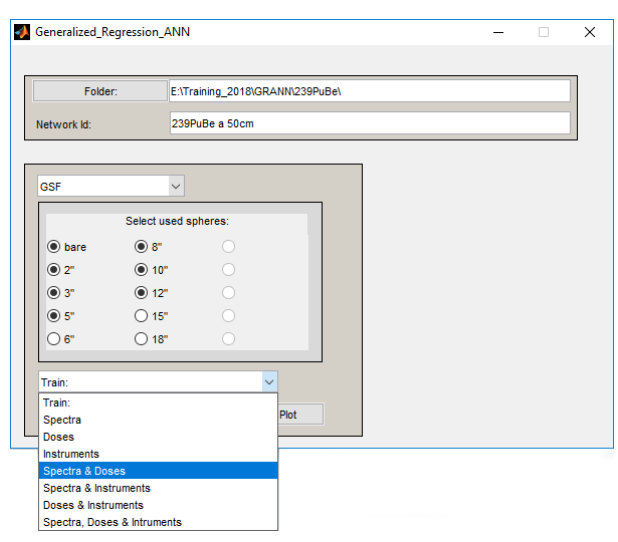
Figure 11. Selection window for training a GRANN with several options